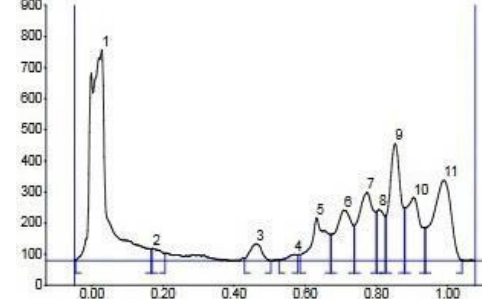
Fig. 19. Soxhalation fruit extract, HPTLC chromatogram of methanolic fruit extract of M. cymbalaria